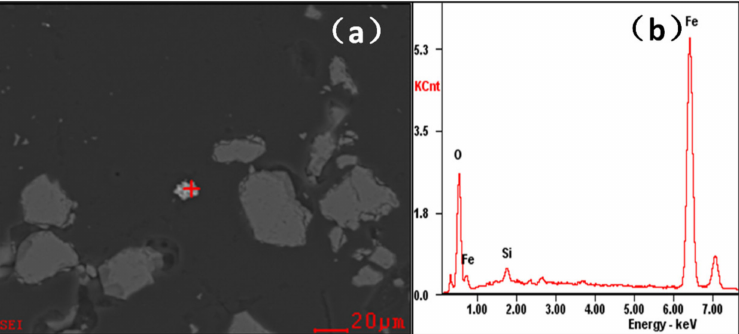
Figure 3. SEI image and spectrum of orthoclase in NPQ. ( a ) SEI image of quartz and orthoclase, ( b ) Energy spectrum of quartz, ( c ) Energy spectrum of orthoclase.